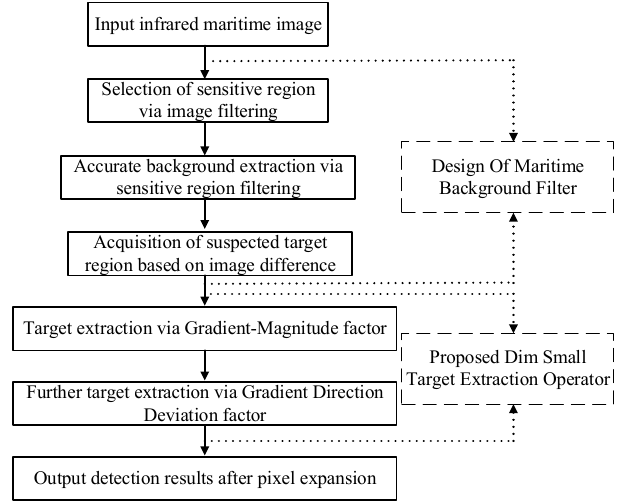
Figure 8. Flow chart of the proposed algorithm (SRGM).